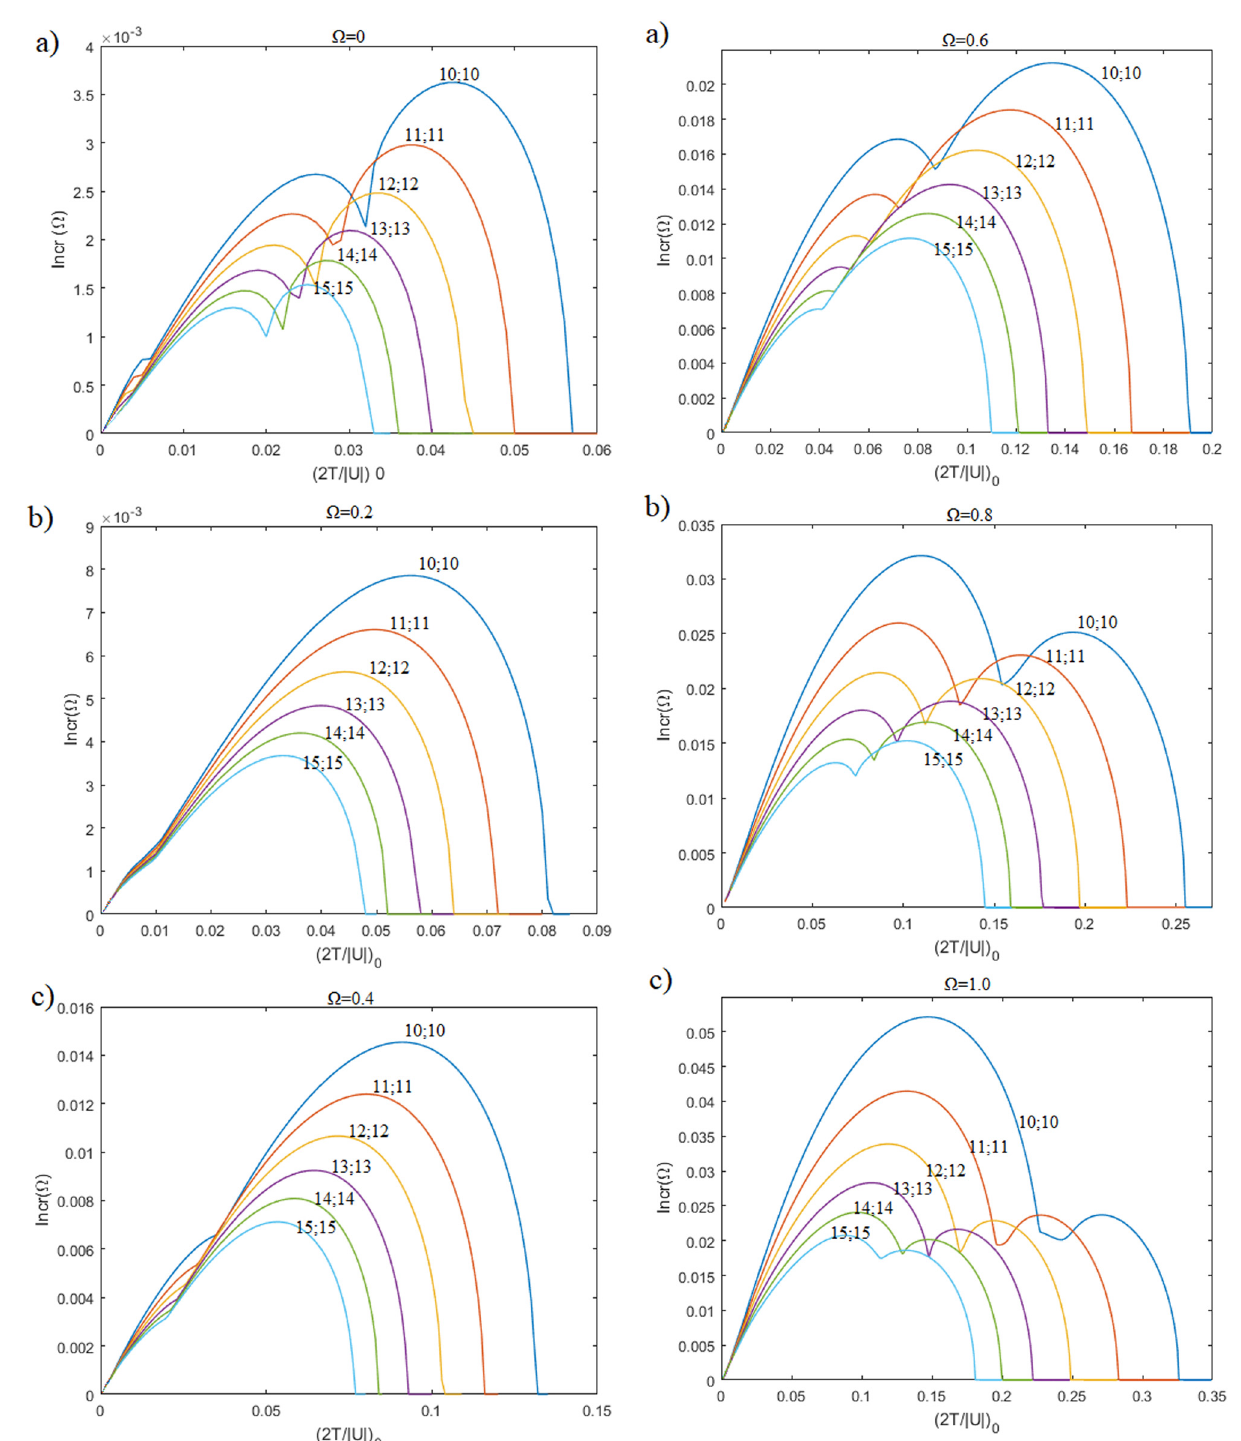
Figure 8: ( a to c ) Comparison of the increments of instabilities of all small - scale oscillation modes for di ff erent values of the rotation